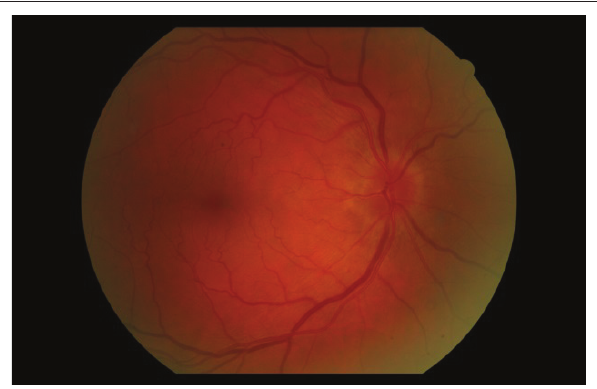
FIGURE 1: Right eye fundus photograph of patient with ethambutol toxic optic neuropathy.